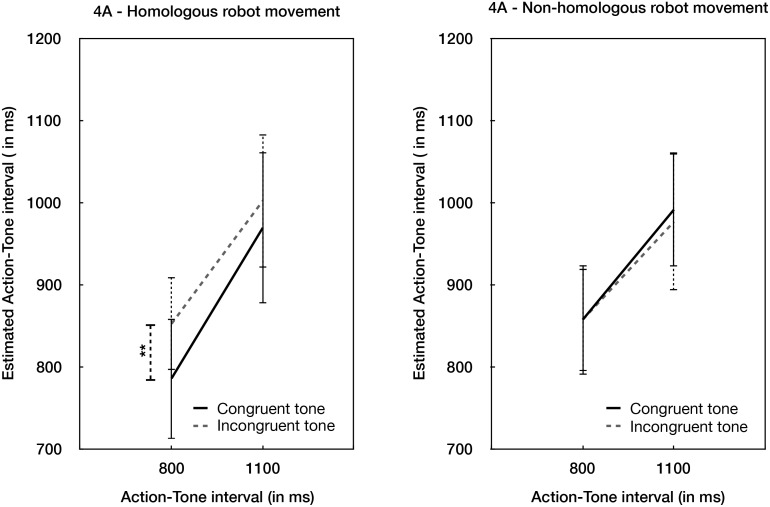
Behavioural results.(A) Interval judgment estimation in the two experimental conditions in which the robot movement was homologous with the participant’s movement. (B) Interval judgment estimation in the two experimental conditions in which the robot movement was non-homologous with the participant’s movement. ** indicates a significant difference (two-tailed p < .01). Error bars refer to standard errors. All the tests were two-tailed.